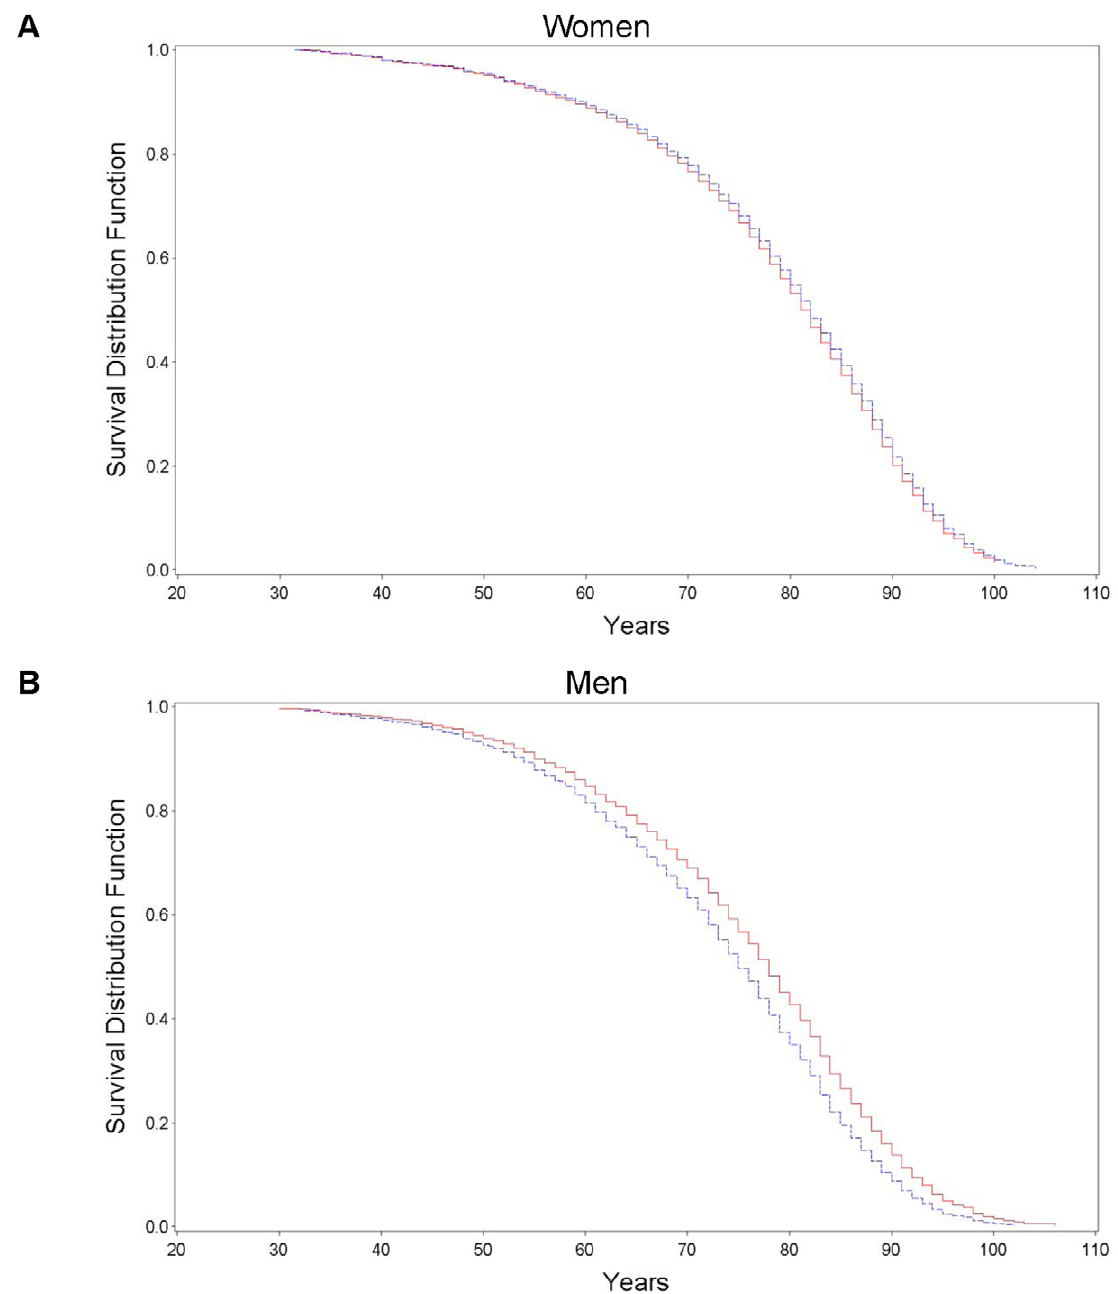
Figure 1. Survival curves of Old Order Amish (red solid line) and Framingham Heart Study (blue hatched line) among those surviving until at least age 30 years.